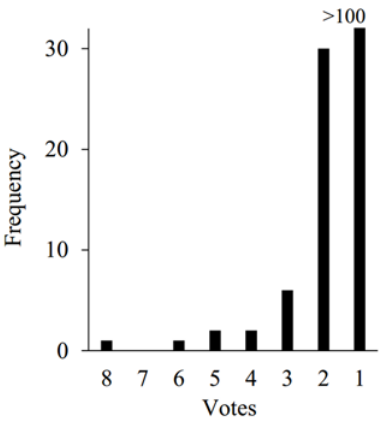
Figure 5. The frequency of votes of the selected features in the candidate feature pool.